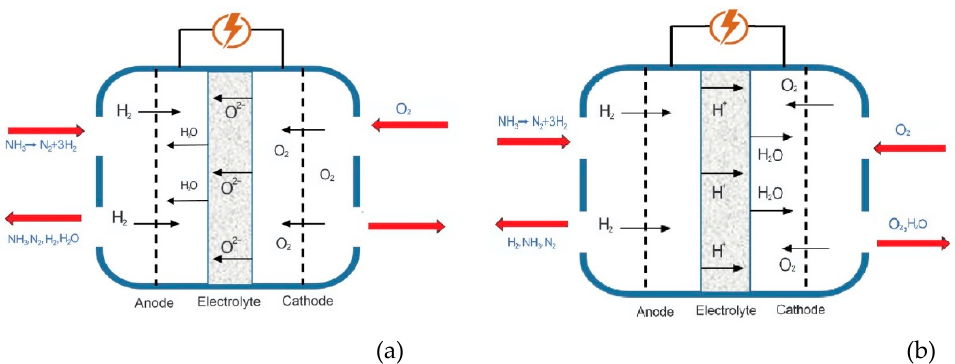
Figure 7. Schematic representation of ( a ) SOFC-O and ( b ) SOFC-H [27].